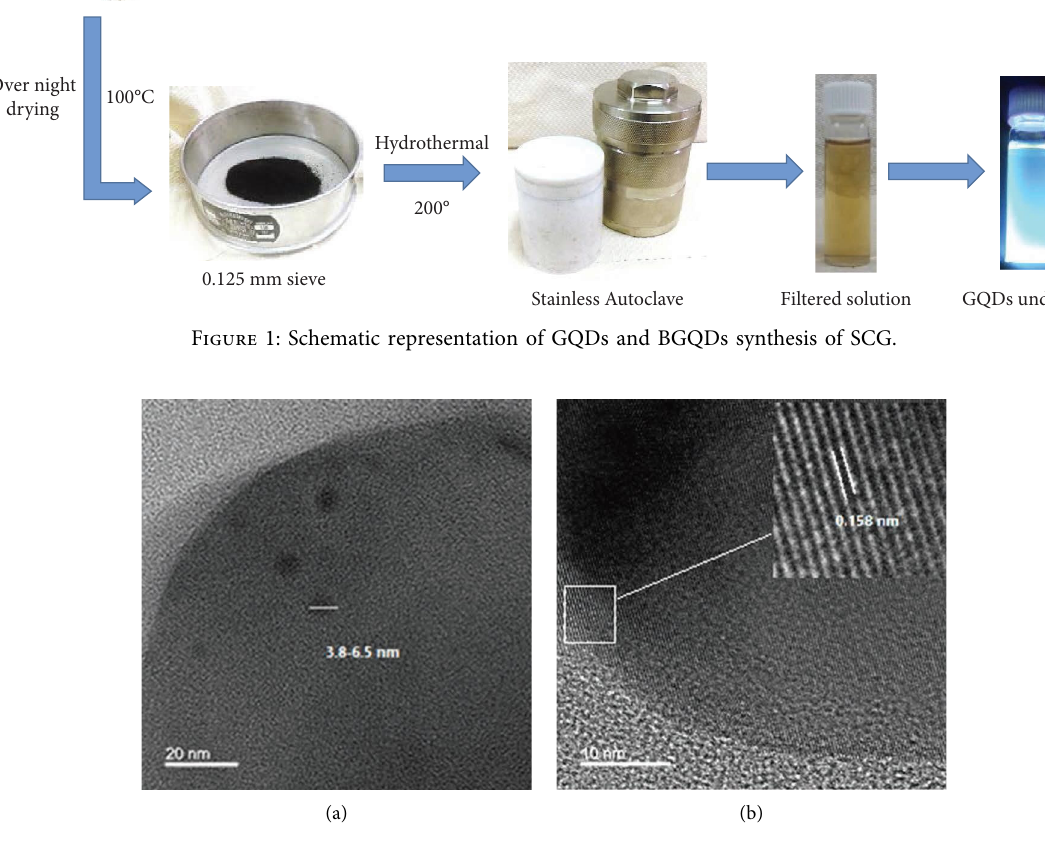
Figure 2: HRTEM images of BGQDs prepared in a single step hydrothermal